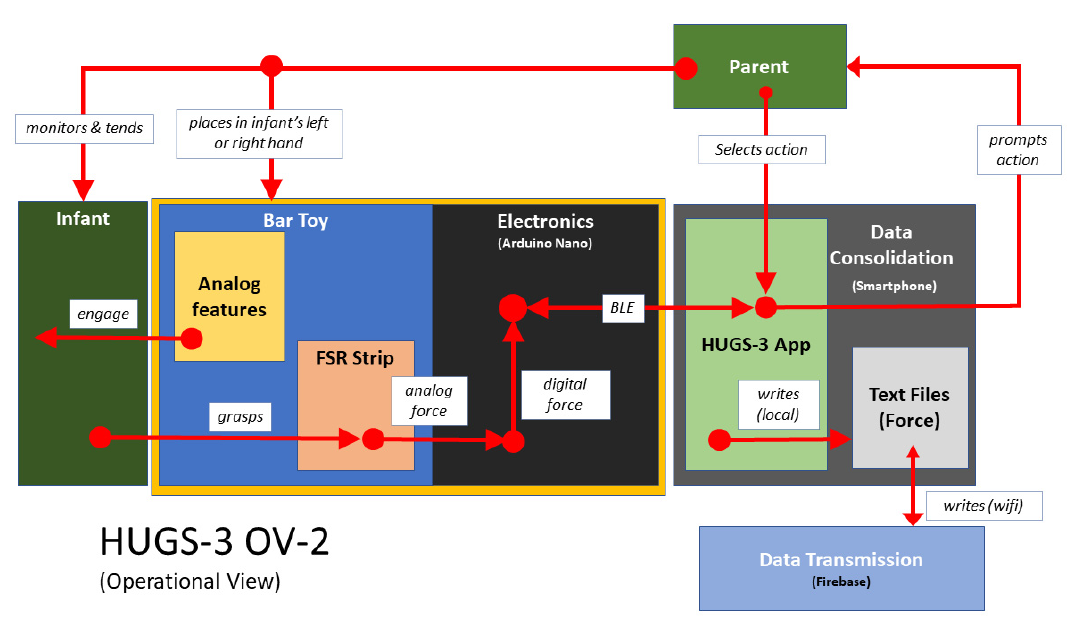
Figure 12. HUGS ‐ 3 system components and